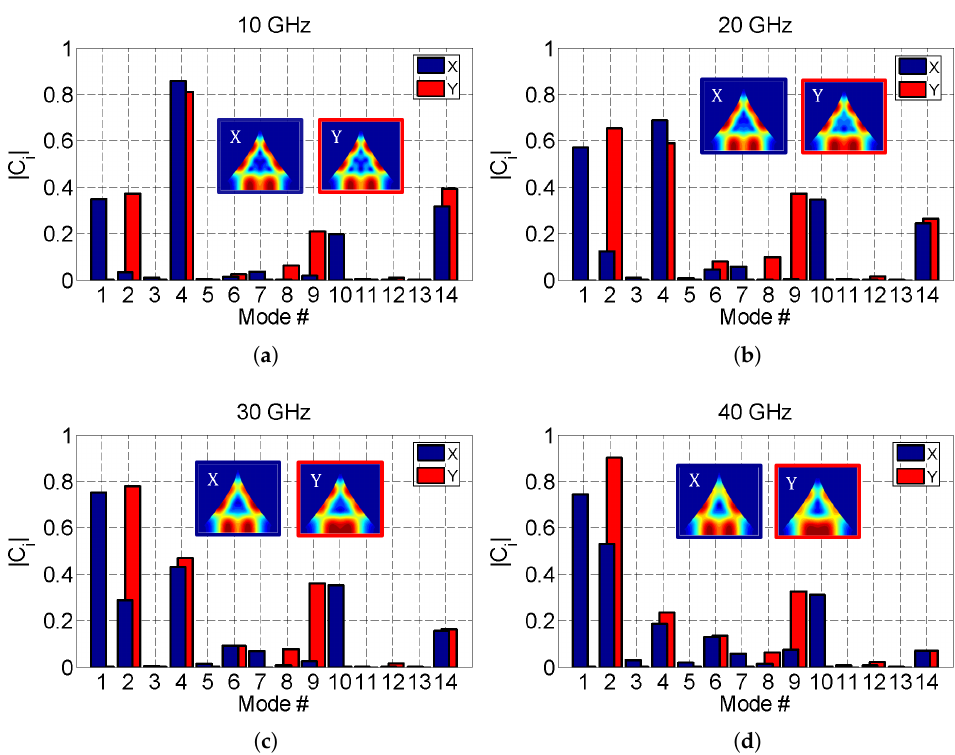
Figure 10. Normalized magnitude of the coefficients C i in the glide-symmetric configuration for wave propagation in x and y directions at different frequencies: ( a ) 10GHz, ( b ) 20GHz, ( c ) 30GHz, ( d ) 40GHz. The normalized magnitude of the tangential electric field, calculated according to (1), is also displayed for both propagating directions. The geometrical parameters of the considered unit cells are: h hole = 1.5mm, g = 0.2mm, h t = 3mm, and d x = d y = 4.5mm. The dispersion diagram of the structure is displayed in the green curve of